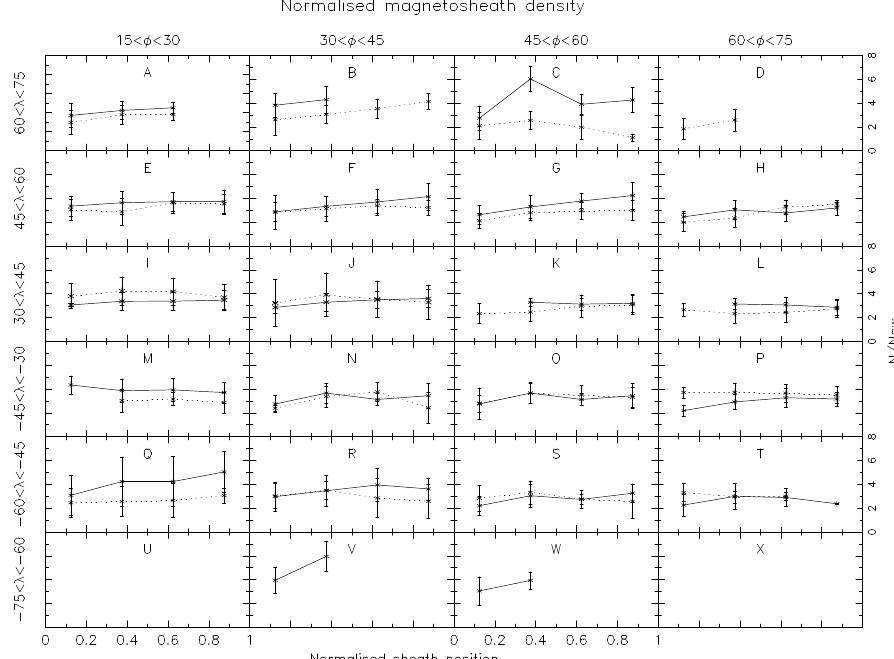
Fig. 7. Normalised density ratios presented in same format as for Fig. 6, with GSE longitude, φ increasing from left to right and GSE latitude, λ decreasing from top to